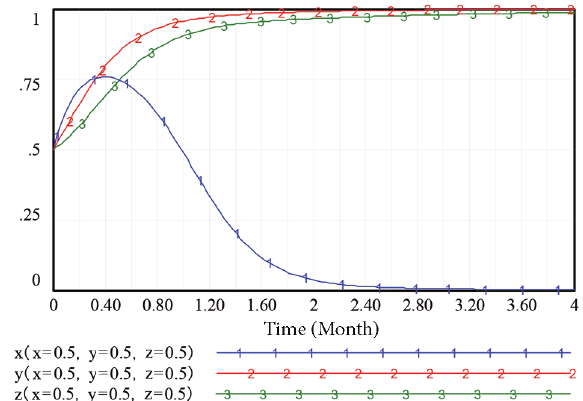
Figure 13. Game results under dynamic penalty–reward control